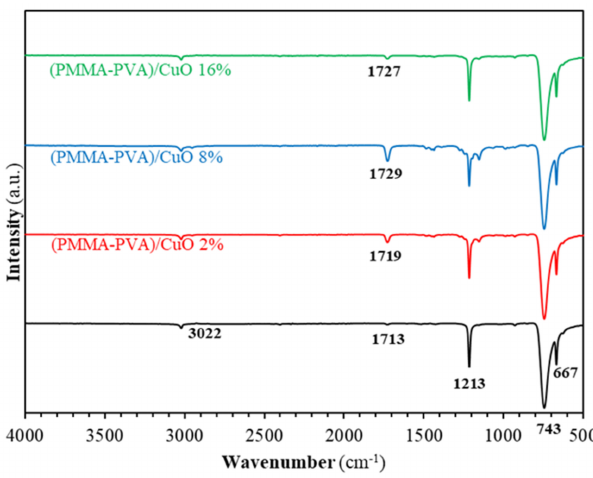
Figure 13. FTIR spectra of doped and undoped for PMMA–PVA/CuO nanocomposite thin films.